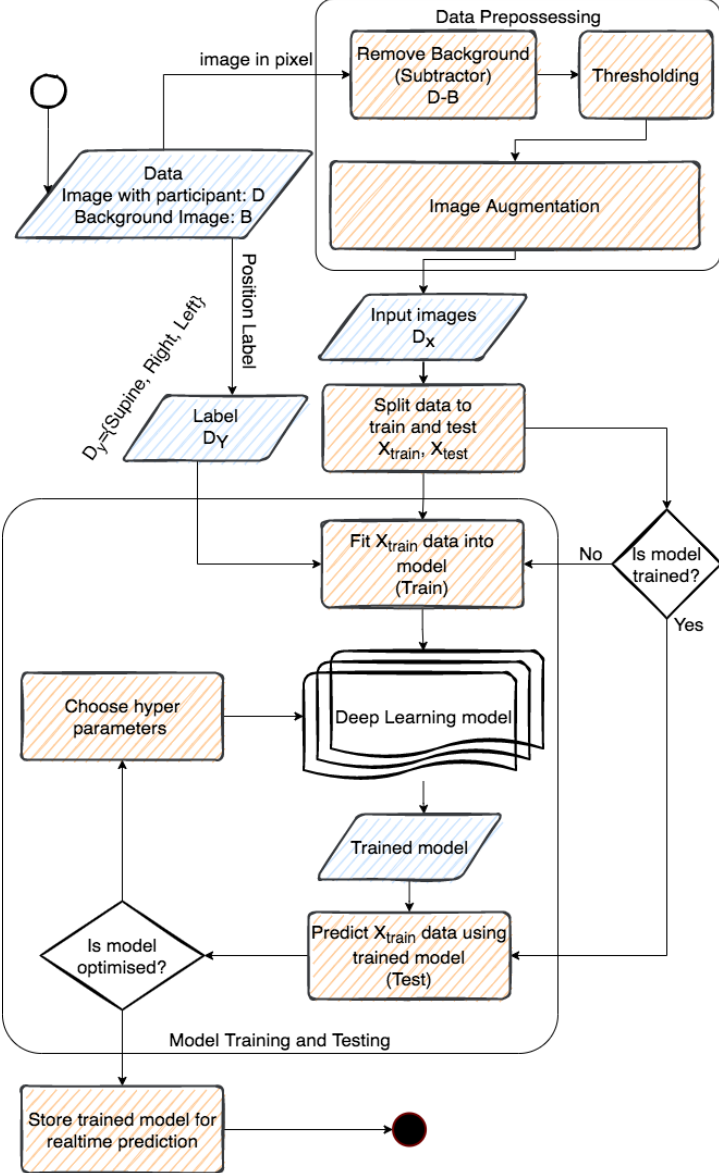
Figure 1. Overall System Methodology